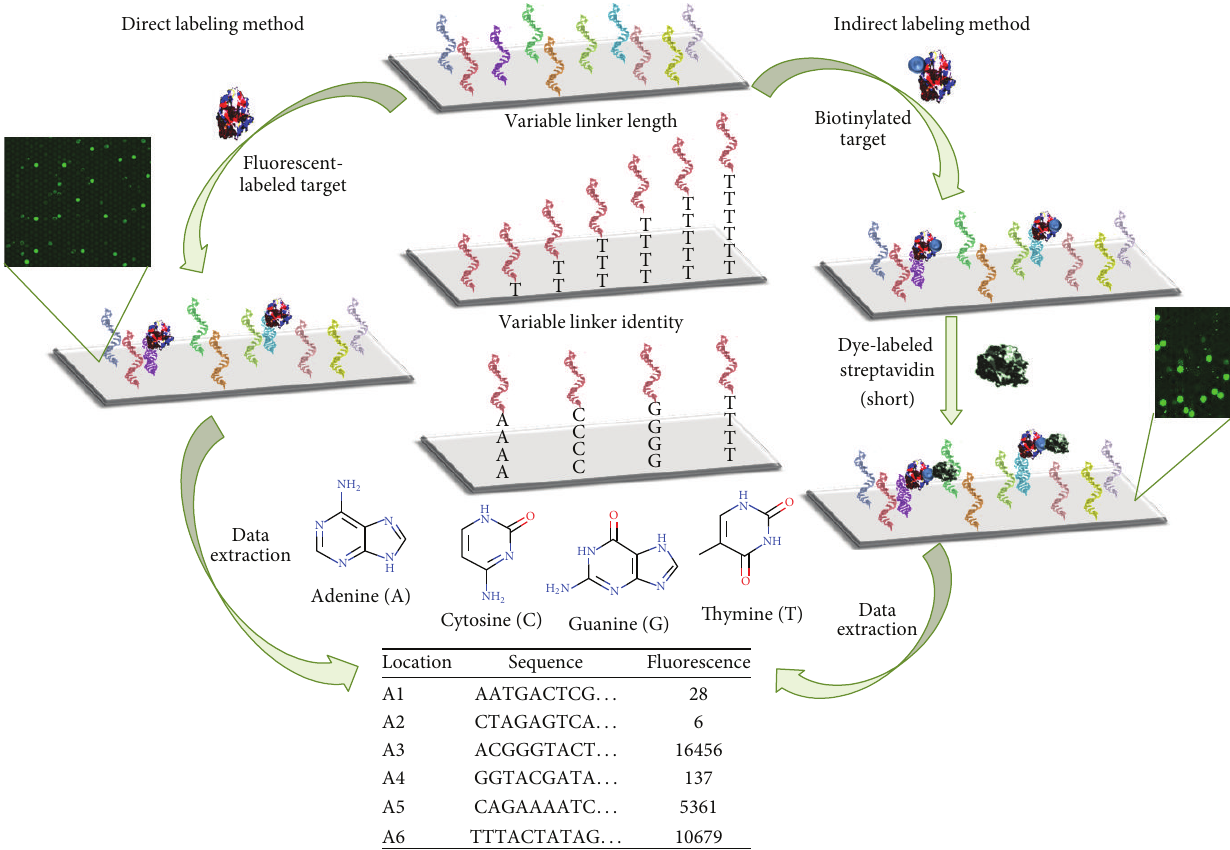
Figure 1: Diagram of variables investigated in the current experiment. Linker length: the distance from the microarray surface was varied; linker identity: nucleobase (adenine, cytosine, guanine, or thymine) was used to tether aptamers to the surface; direct labeling method: fluorescent reporter dye conjugated directly to the target molecule is incubated with aptamer microarray; indirect labeling method: biotinylated-target is added to microarray, followed by a short dye-streptavidin incubation with aptamer microarray. Following incubation, all microarrays were washed and imaged and the data was extracted in order to link fluorescence intensity location with aptamer sequence. Nucleobase structures were created using VIDA, part of OpenEye